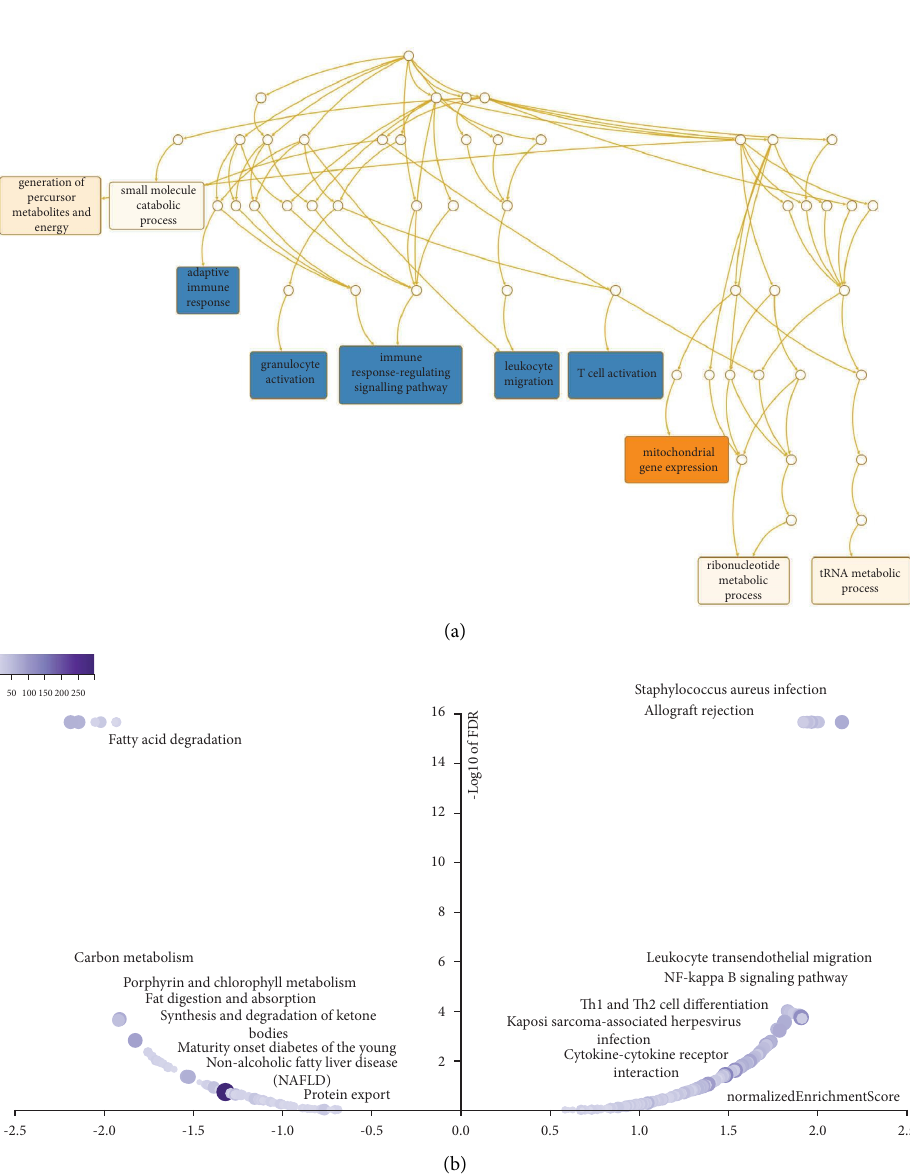
Figure 3: DPP4 enrichment analysis in THCA. (a) GO analysis (biology process) shows that DPP4 and its coexpressed genes are mainly involved in adaptive immune response, granulocyte activation, the immune response-regulating signaling pathway, leukocyte migration, and Tcell activation. (b) KEGG pathway analysis indicates that DPP4 coexpression genes enrich in leukocyte transendothelial migration, the NF-kappa B signaling pathway, T1 and T2 cell diferentiation, and cytokine-cytokine receptor